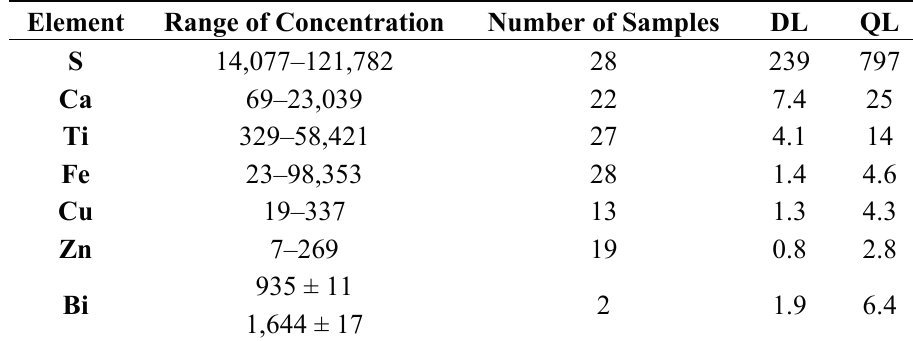
Table 1. Range of concentration for nail polishes with the respective detection limit (DL) and quantification limit (QL). Values in mg·kg − 1 .